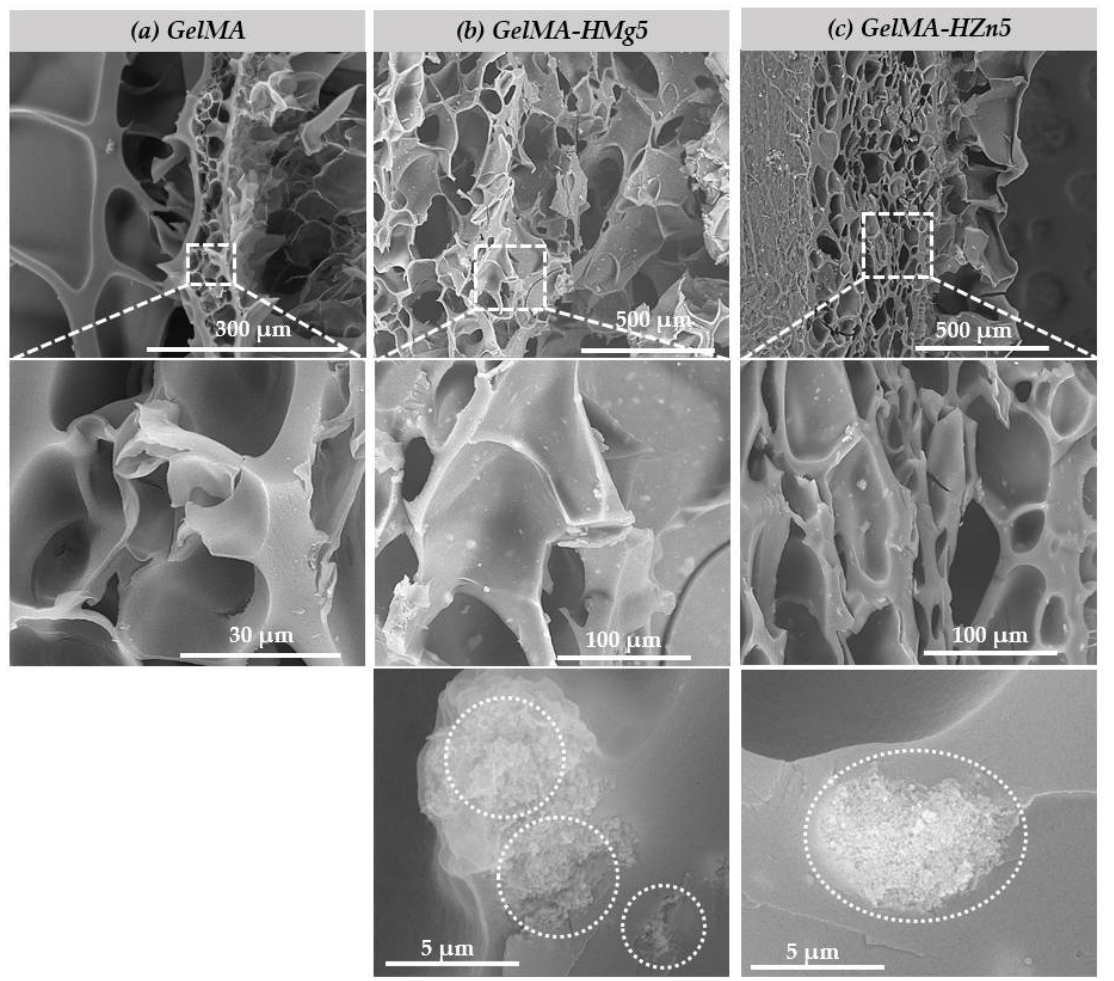
Figure 7. SEM micrographs of samples ( a ) gelatine methacrylate (GelMA), ( b ) GelMA with magne- sium (GelMA-HMg5), and ( c ) GelMA with zinc (GelMA-HZn5) .